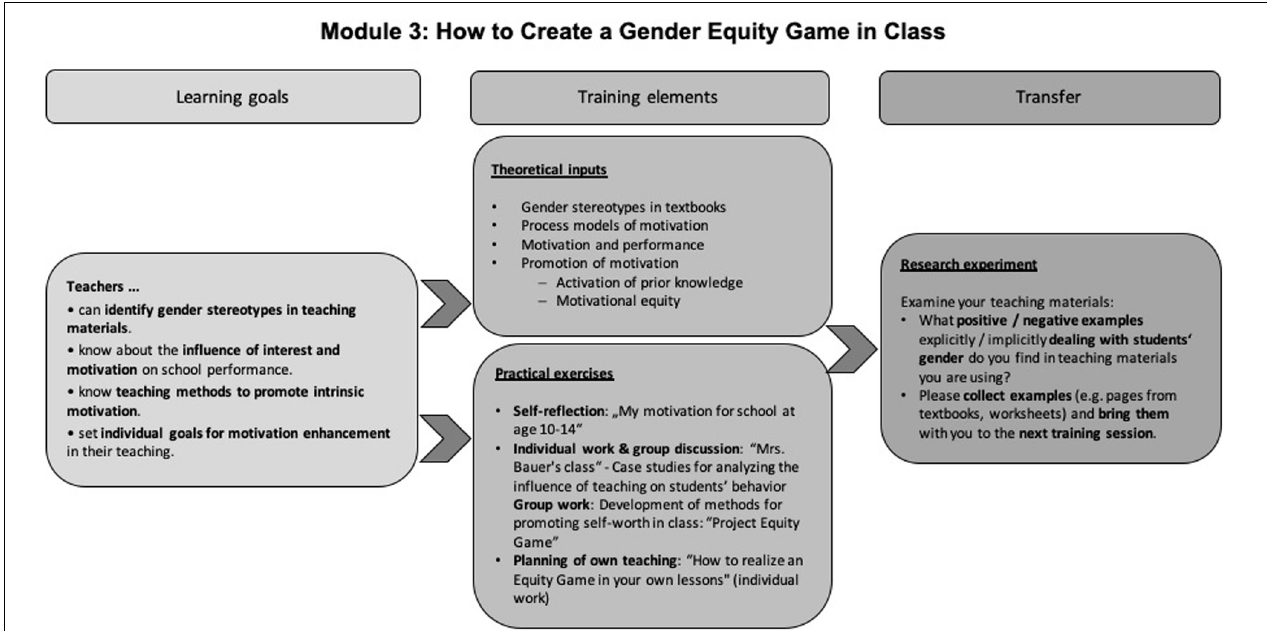
FIGURE 2 | Training goals and contents of Module